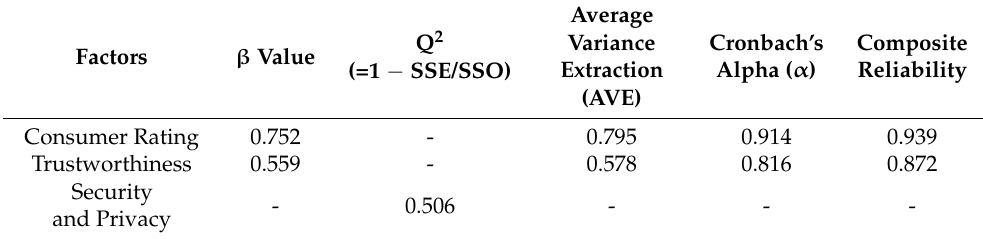
Table 7. Predictive relevance of model factors for OUNAS.